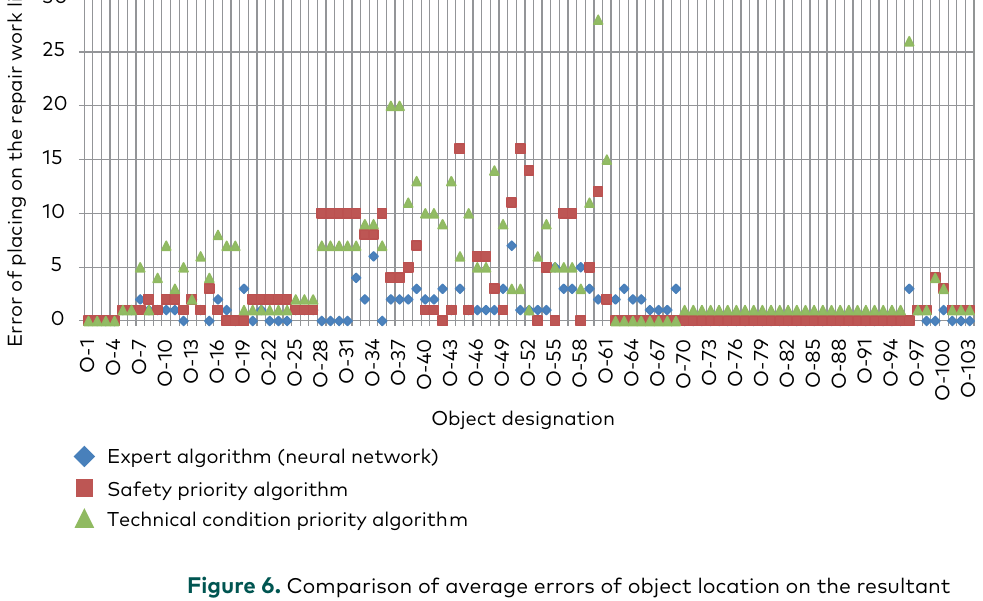
Figure 6. Comparison of average errors of object location on the resultant ranking list